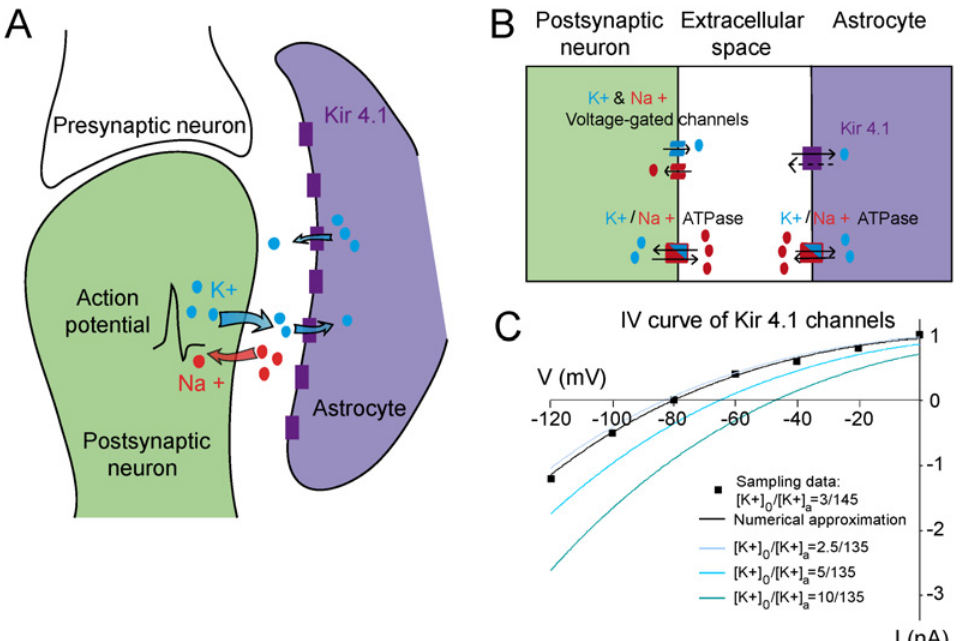
Fig 1. Tri-compartment model of the potassium cycle between the neuron, the extracellular space and the astrocyte. A, Schematic representation of the tri-compartment model: neuronal activity induces the release of K + in the extracellular space, which is taken up by astrocytes. B, Reduction of the tri- compartment model to ionic fluxes exchanges between a generic postsynaptic neuron, astrocyte and extracellular space. The model includes channels and pumps carrying K + and Na + ions. C, Current-Voltage relationship (I-V curve) of K ir 4.1 channels. We identify the free parameters in equation 22 by fitting the simulated IV curve (light blue) to experimental recordings performed in isolated astrocytes (sampling data, black rectangles) [65]. Using equation 22, we plot the I-V curve for different ratios of extracellular to intracellular astrocytic K + concentrations (2.5/135 (light blue), 5/135 (blue) and 10/135 (dark blue). At resting membrane potential (-80 mV) and resting [K + ] o (2.5 mM), the K ir 4.1 current is outward, but as illustrated here, it reverses by increasing [K + ] o .